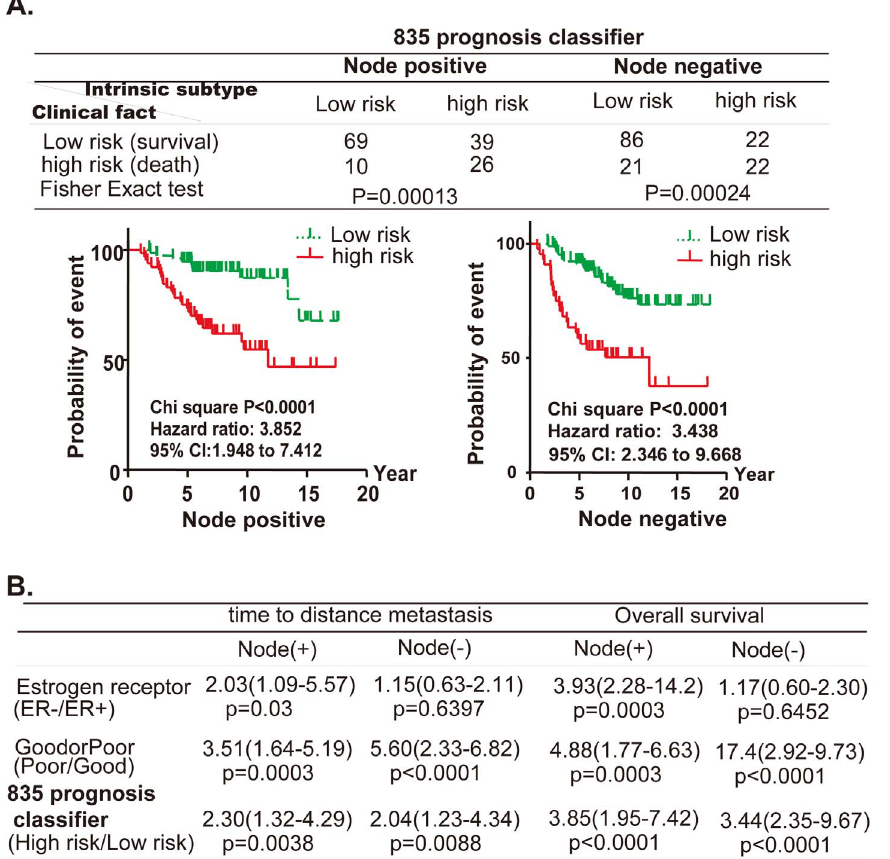
Figure 6. The 835 prognosis classifier could predict clinical outcome in a large set of breast cancer patients. The intrinsic dataset was applied to 144 node positive and 151 node negative primary breast tumors. The accuracy of prediction ( A ) or the prognosis value ( B ) of 835 prognosis classifier and tumor risk factors was assessed by the same approach as described in the legend of Fig. 5.